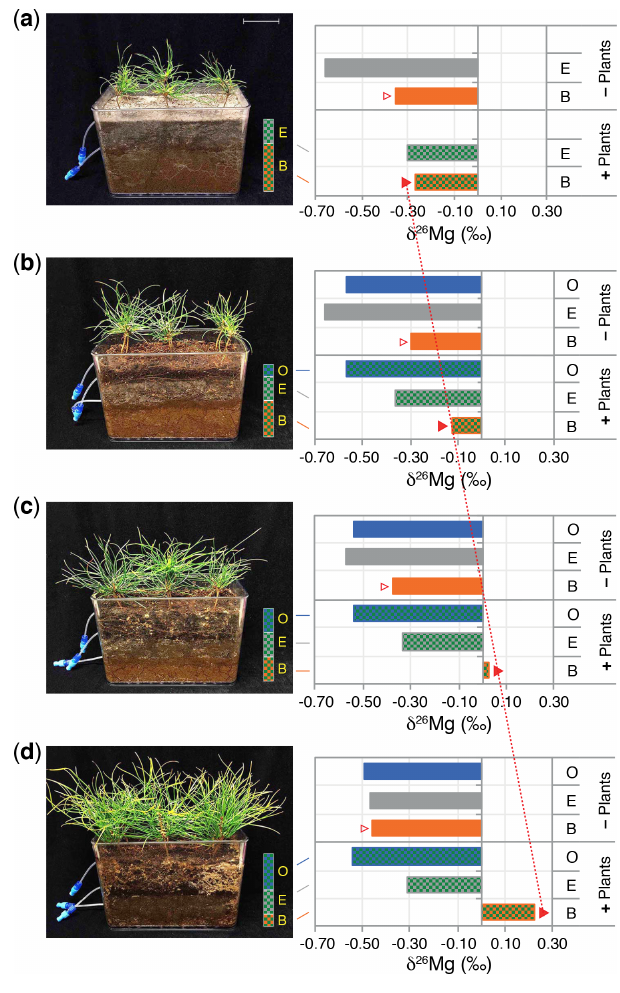
Figure 6. Mesocosms containing reconstructed podzol soil profiles with different amounts of organic (O) horizon material to simu- late different intensities of forest harvesting. (a) No O horizon; (b) 50% thickness O horizon; (c) normal (100%) thickness O hori- zon; (d) 150% thickness O horizon. The histograms show levels of enrichment of 26 Mg in soil solution extracted from the O (organic), E (eluvial) and B (illuvial) horizons. The upper part of each diagram represents systems incubated without plants, the lower part of each diagram represents systems containing Pinus sylvestris seedlings (as illustrated). Note that the seedling growth is proportional to the amount of organic soil, from which ectomycorrhizal fungi mobilise N. The enrichment of 26 Mg in the soil solution becomes greater and greater with increasing plant growth (and therefore increasing Mg uptake) – but only in the B horizon, because there is discrimination against uptake of the heavy isotope. This suggests that the B hori- zon is the primary site of active mineral weathering and Mg uptake. Extensive colonisation of roots and organic and mineral substrates by ectomycorrhizal mycelia is visible. Horizontal scale bar in (a) is equal to